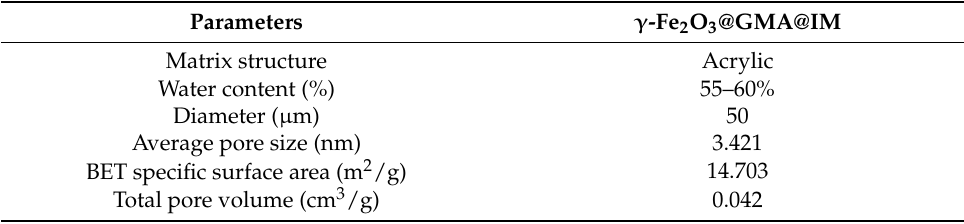
Table 1. Physicochemical parameters of γ -Fe 2 O 3 @GMA@IM.